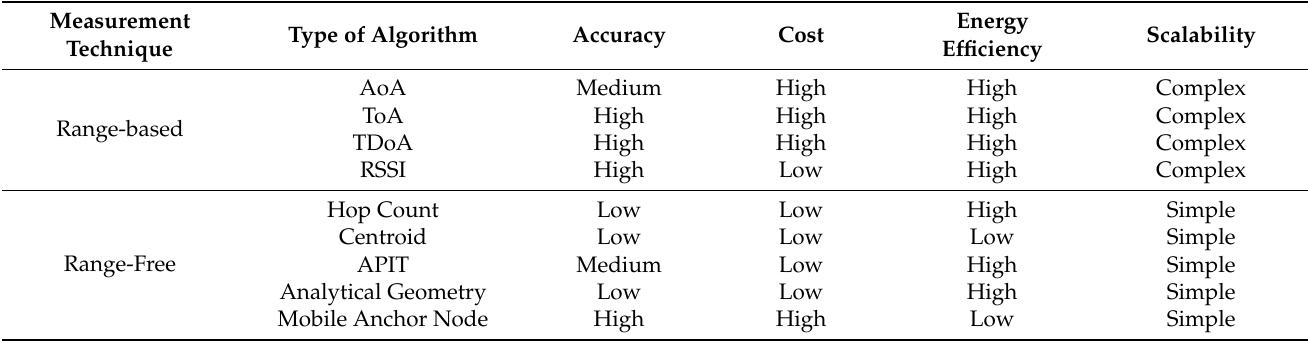
Table 2. Comparison of Measurement Techniques.